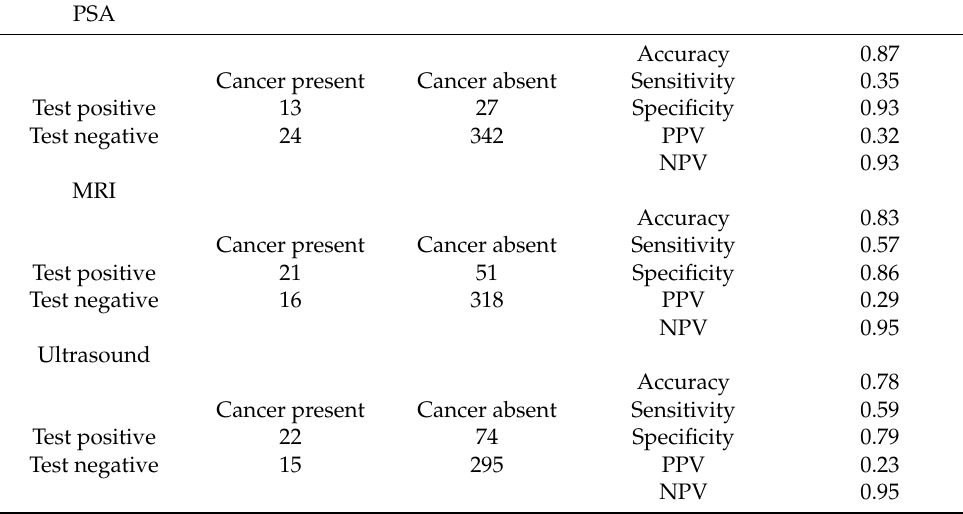
Table 1. Individual accuracy of PSA, MRI, and ultrasound techniques in PCa detection in the PROSTAGRAM screening study [11]. Both significant (Gleason 7) and insignificant (Gleason 6) cancers that were considered as a positive diagnosis in this study.